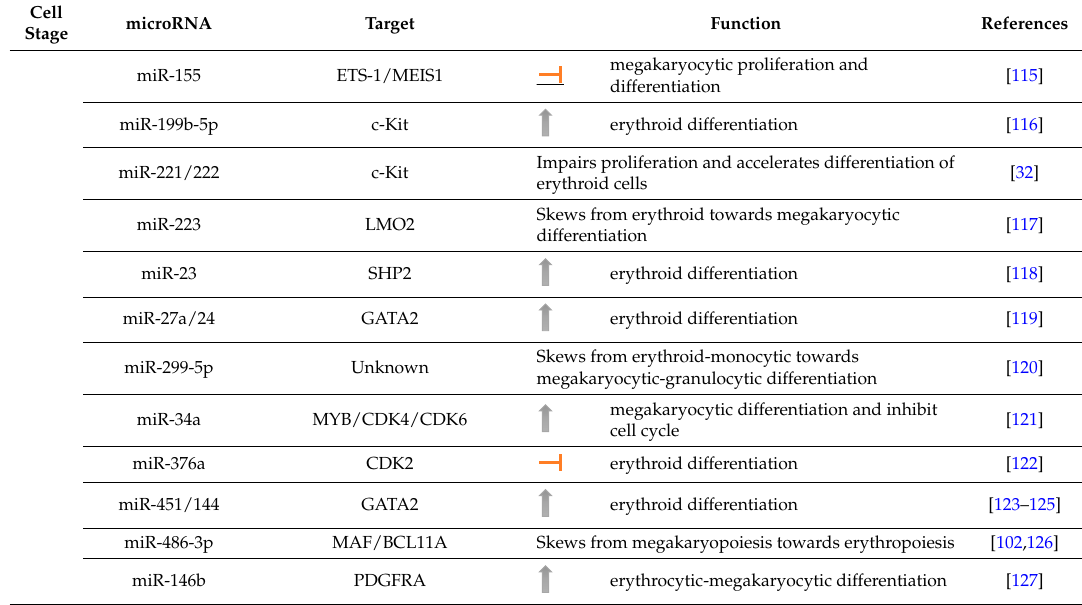
Table 1. miRNAs involved in myelopoiesis which are involved in key (stem) cell processes (differentiation, self-renewal, apoptosis and proliferation) and their identified targets.